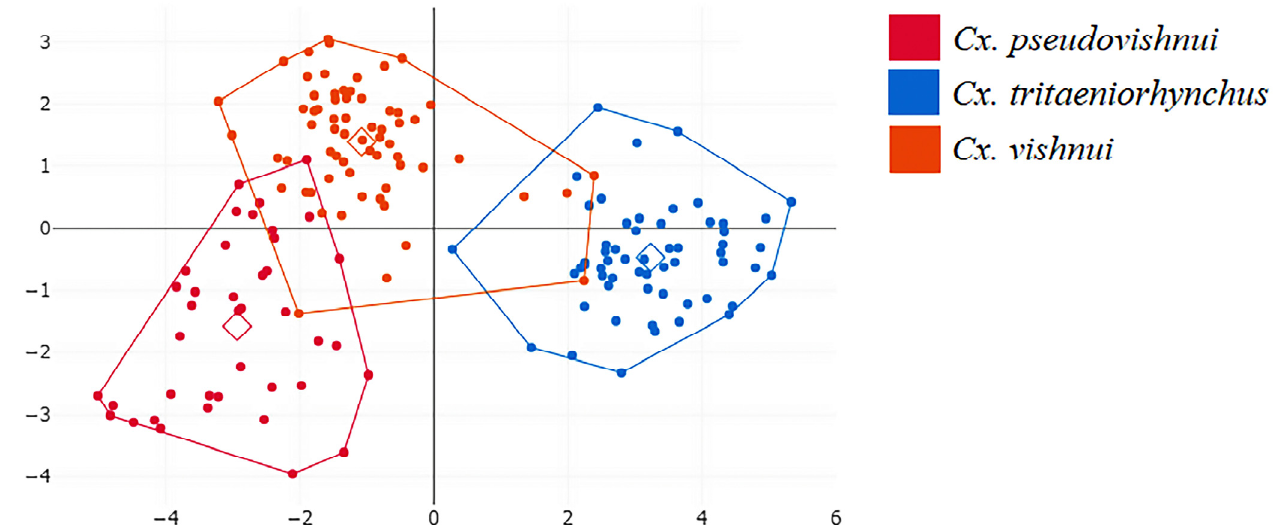
Figure 6. Factor map generated by discriminant analysis of shape variables for Cx. pseudovishnui , Cx. tritaeniorhynchus , and Cx. vishnui . The wing shape variations of each Culex species are represented by each polygon, and each dot within the polygons represents an individual Culex specimen. Table 2. Statistical differences of Mahalanobis distance values based on wing shapes of Cx. Pseu- dovishnui , Cx. tritaeniorhynchus , and Cx. vishnui .